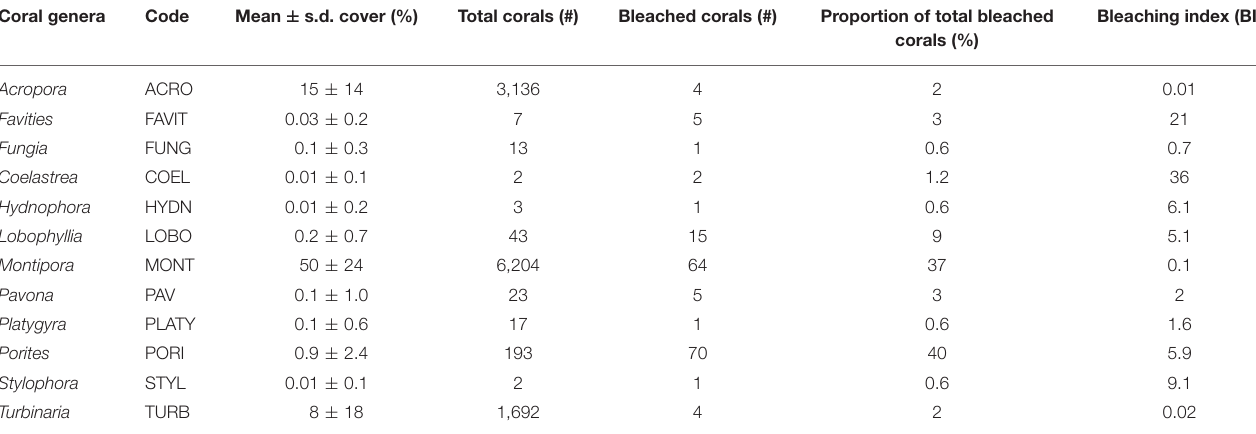
TABLE 1 | Summary of taxa-specific responses to thermal stress of coral on Paluma Shoals reef complex following the 2016 ocean warming event. Coral